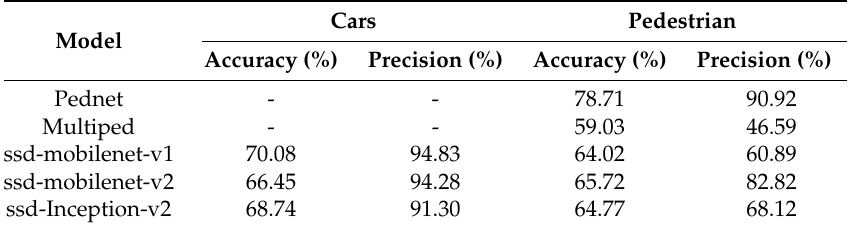
Figure 11. Results for the object detection of the pedestrians in each of the five networks on four different test images. Blue and green boxes represent normal detections. Pednet predicts all pedestrians in the images with the highest accuracy followed by Multiped. Table 4. Average performance of models on embedded board